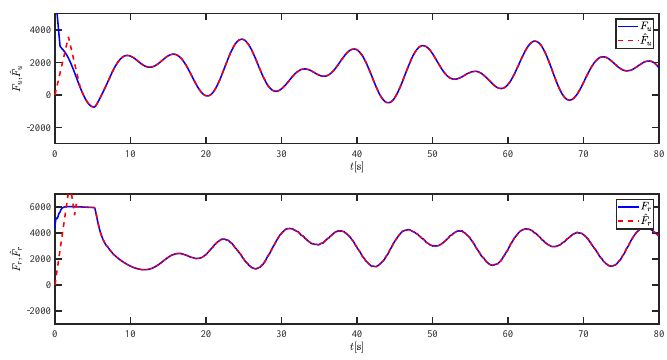
Figure 8. The lumped disturbances and their estimations at moderate speed.